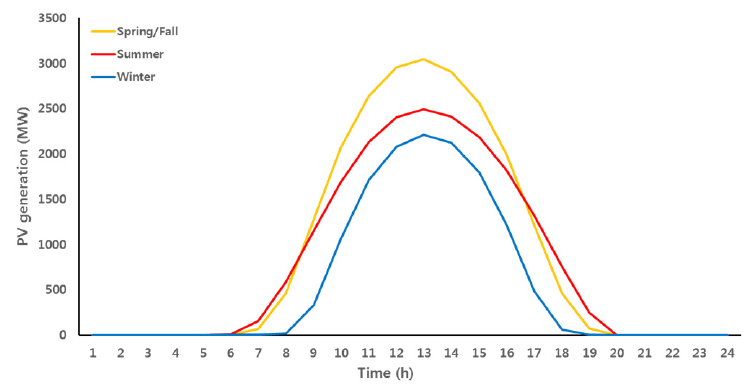
Figure 3. Seasonal PV generation curves of 2017. Table 4. Load growth rate from 2018 to 2030 [16].